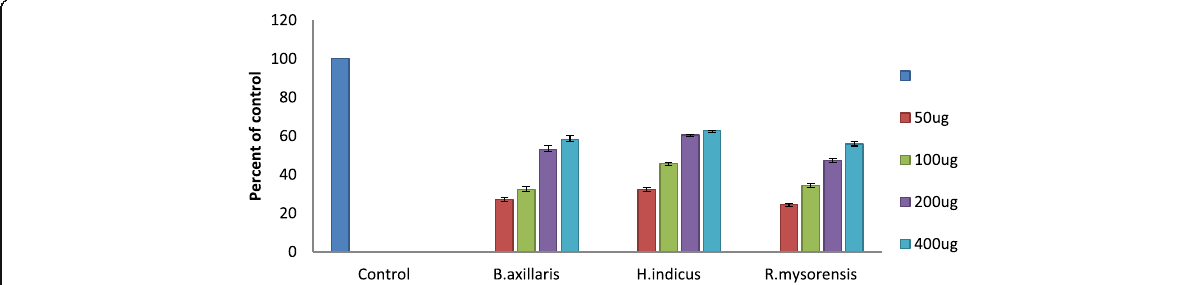
Fig. 3 Neurotoxic effects of B.axillaris, H.indicus and R.mysorensis on SK N SH cells of human neuroblastoma cell line as assessed using MTT assay. Control cells cell viability was taken as 100%